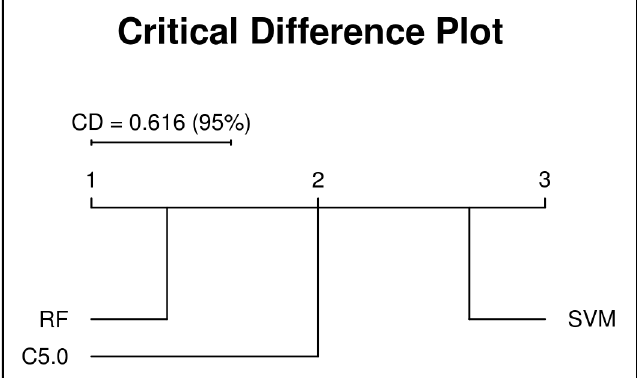
Figure 6. Critical differences plot of the pairwise Nemenyi comparison test for the full datasets 10-folds cross-validation experiment.